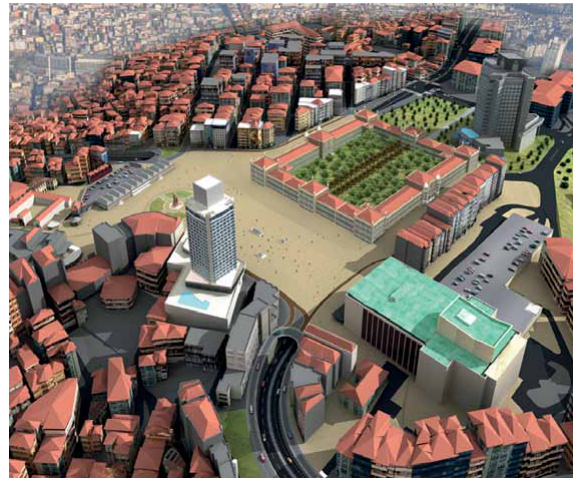
fig. 6. an illustration of the Taksim pedestrianisation